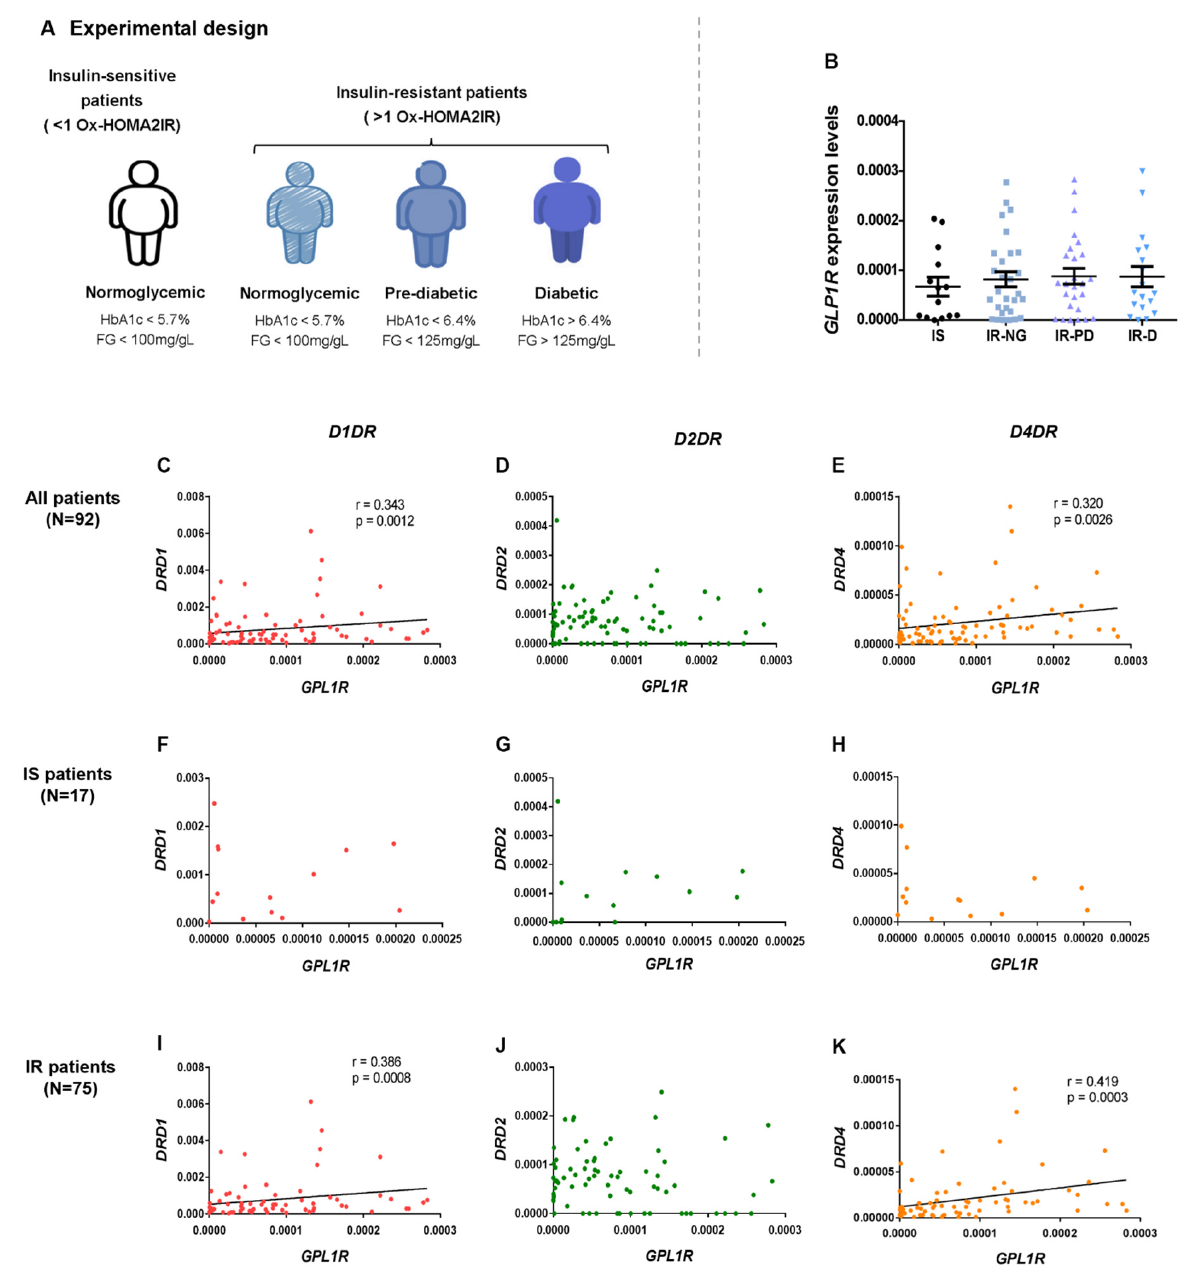
Figure 3. GLP1-R expression in patients with metabolic dysfunction and its correlation with dopamine receptors expression. Expression of GLP1R did not alter between groups of obese patients with different grades for glucose and insulin dysmetabolism ( B ). GLP1R expression correlates with decreased expression of DRD1 and DRD4 in all groups of insulin resistance patients (( C , I ); ( E , K )) but not in insulin-sensitive patients (( F , H )). GLP1R expression did not correlate with DRD2 for all groups of patients ( D , G , J ). Bars represent the median ± interquartile range. Kruskal-Wallis was used to assess differences between groups (IS: insulin-sensitivity normoglycemic, IR-NG: Insulin resistance normoglycemic, IR-PD: Insulin resistance pre-diabetic, and IR-D: Insulin resistance diabetic patients). Spearman correlations were used to assess the expression of GLP1R correlation with dopamine receptors expression. Levels of significance: 1 symbol, p < 0.05; 2 symbols, p < 0.01; 3 symbols, p < 0.001.